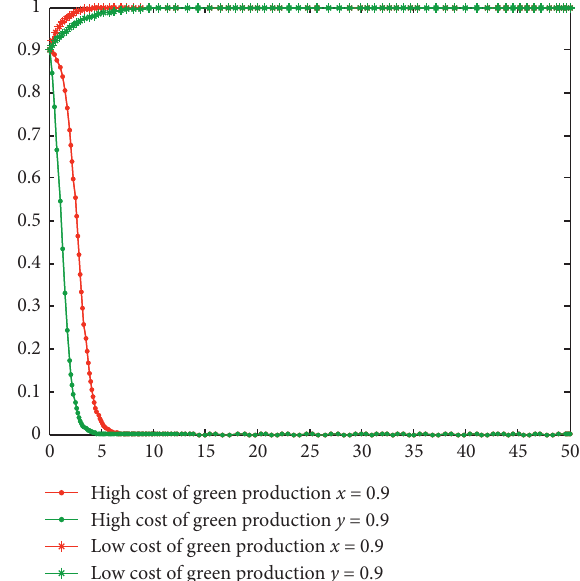
Figure 5: Influence of government subsidy and punishment on the formation of green dairy industry